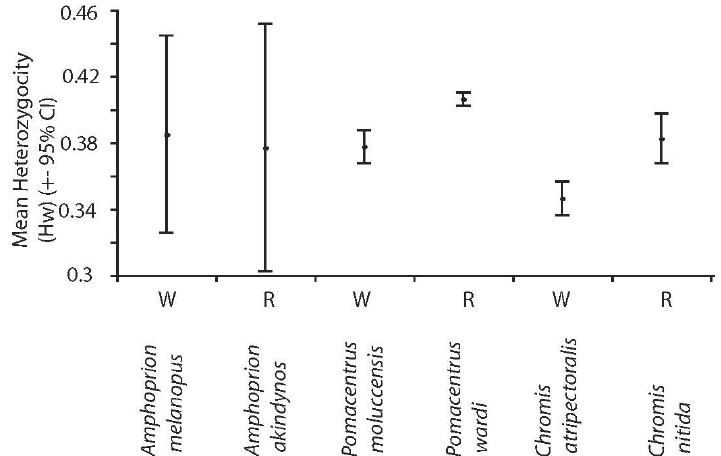
Figure 2. Expected heterozygosity (mean ± 95% confidence intervals) in widespread (W) and spatially restricted (R)